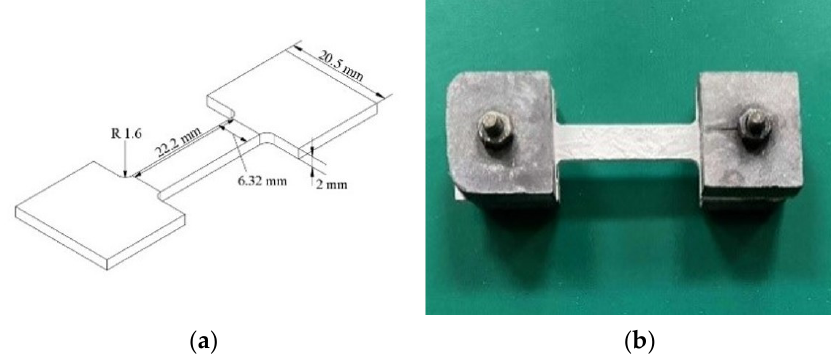
Figure 1. ( a ) Design of the hot tensile test specimen; ( b ) hot tensile fixtures.